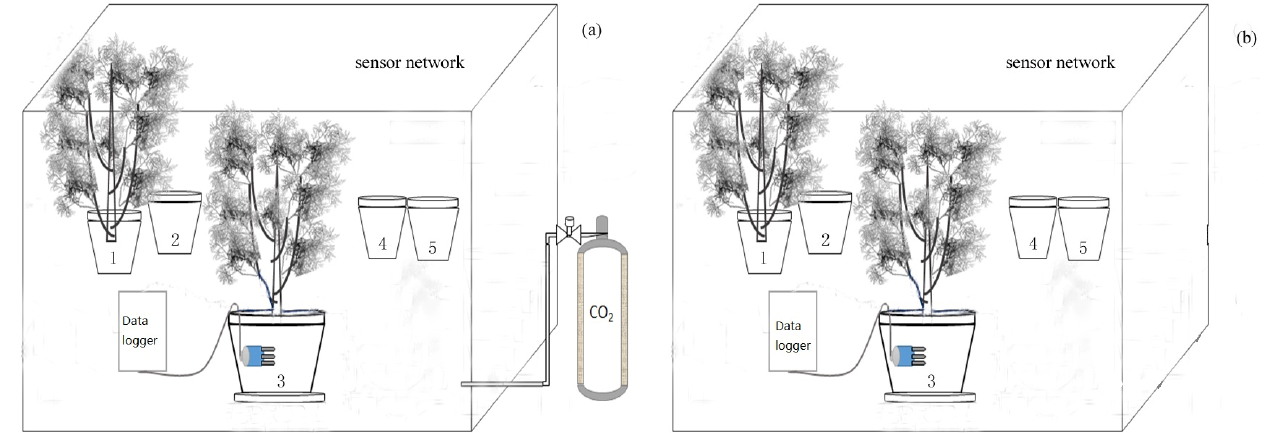
Figure 1. Schematic of growth chambers used in the experiments. One growth chamber ( a ) was used to maintain elevated CO 2 concentration of 600 µ mol · mol − 1 or 800 µ mol · mol − 1 . Another growth chamber ( b ) was used to maintain CO 2 concentration of 400 µ mol · mol − 1 . There were five pots inside each